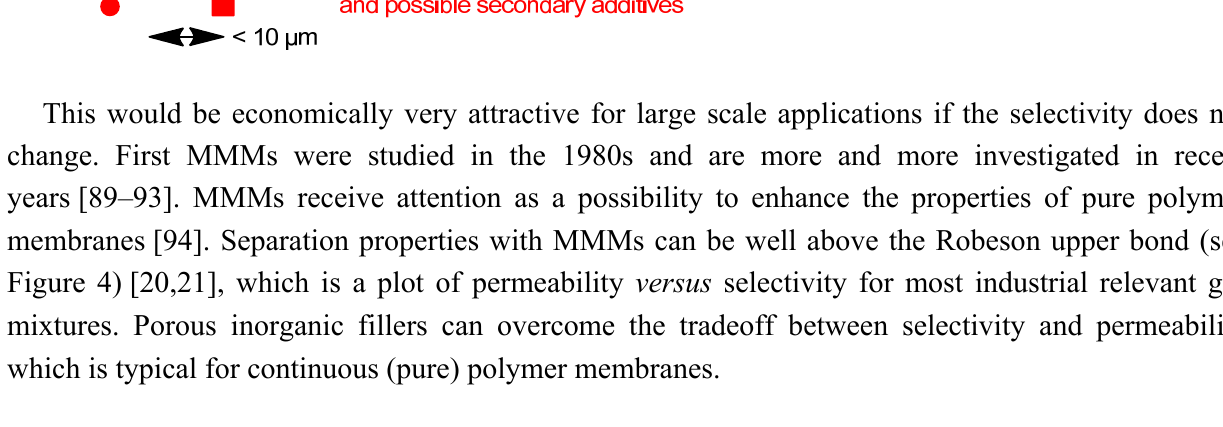
Figure 4. Schematic presentation of the trade-off between permeability and selectivity with the 1991 and 2008 Robeson upper bounds [20,21]. In most cases the technologically attractive region lies around or above the Robeson upper